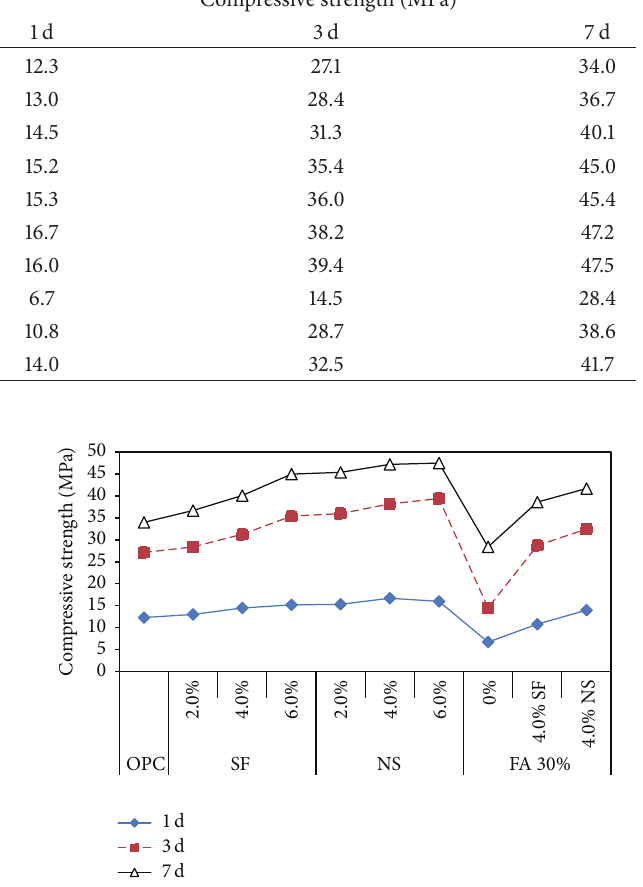
Figure 4: Early-age compressive strength of composite cement